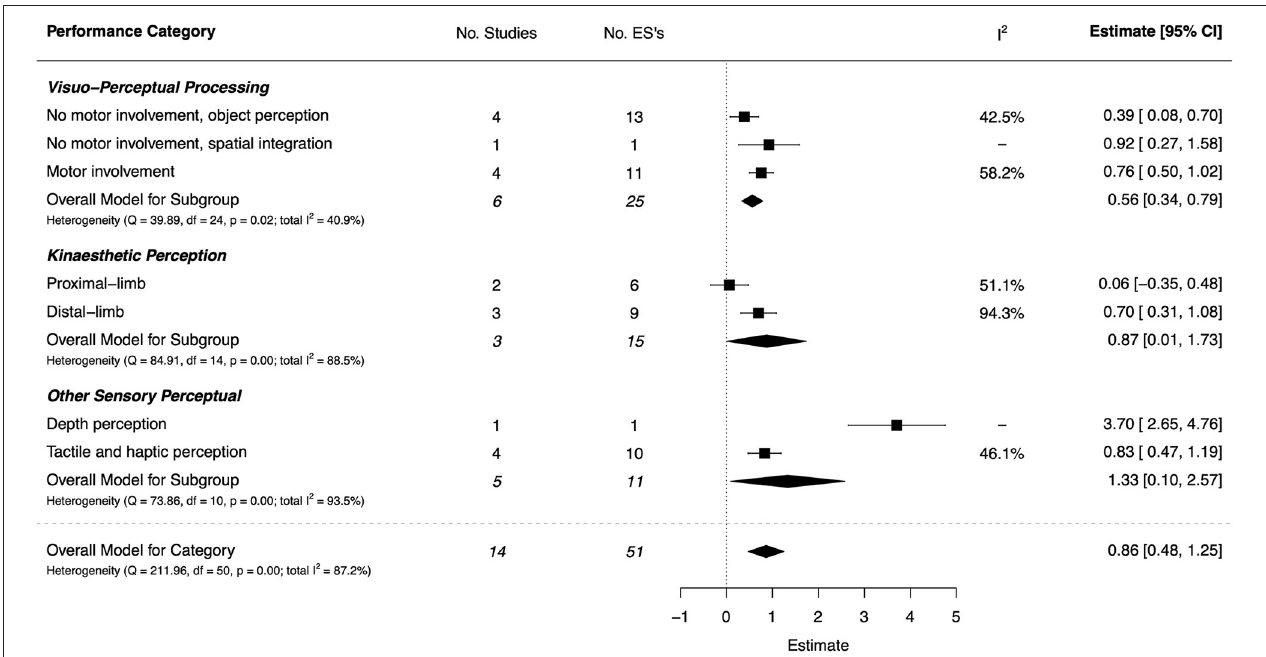
FIGURE 3 | Forest plot showing the meta-analysis results for the sensori-perceptual function performance category.